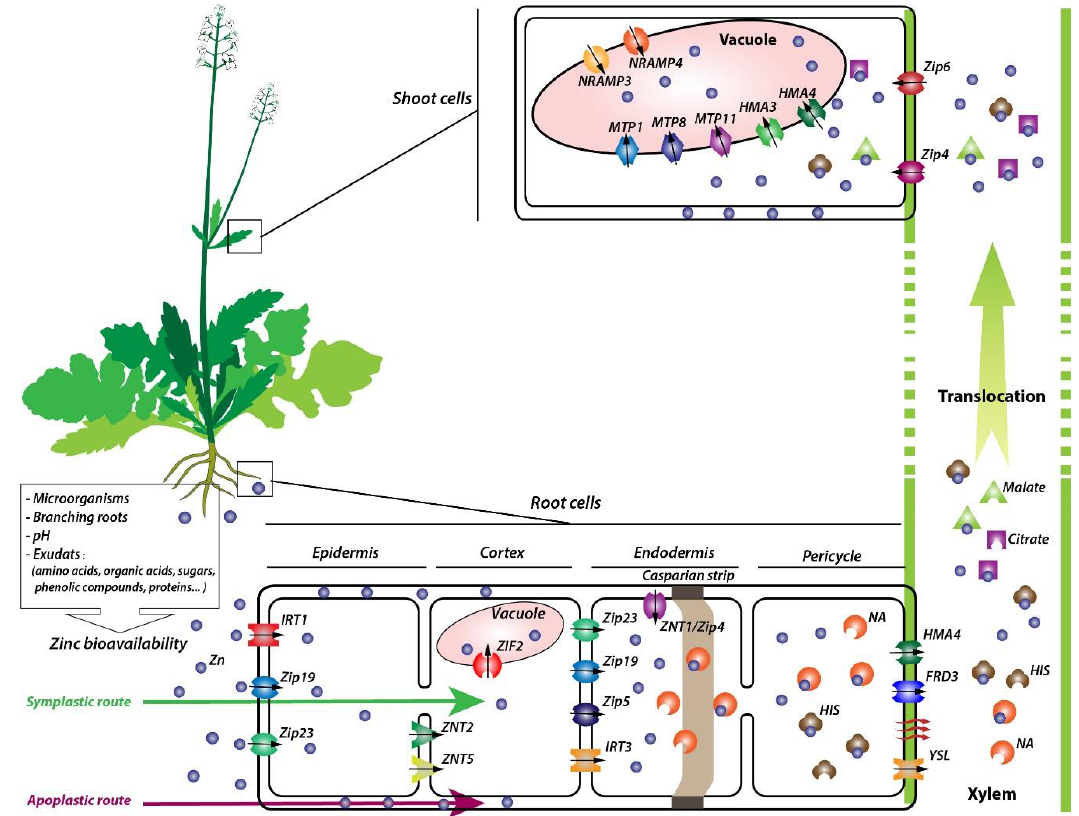
Figure 1. A model of the mechanisms that occur in hyperaccumulation plants upon exposure to zinc (Zn): Zn ion uptake, chelation, transport, and sequestration. Zn bioavailability can be influenced by several factors, such as microorganisms, branching roots, pH, and exudates. Once adsorbed by the roots, Zn can be absorbed by an apoplastic route: A passive di ff usion through cells, or by a symplastic route via transporters. Within the latter path, Zn absorption by epidermis cells is mainly promoted by IRT1, ZIP19, and ZIP23. To reach the cortex, Zn can be directly di ff used or by means of ZNT2 and ZNT5. Then, Zn can either be stocked in vacuoles (promoted by ZIF2) or transported to the endodermis through the following transporters: ZIP23, ZIP19, ZIP5, and IRT3. Zn following the apoplastic route is stopped by the casparian strip, and then enters the endodermis via ZNT1 / ZIP4. At this level, Zn can be chelated by nicotianamine (NA) or directly di ff used to pericycle cells where a part can also be associated to histidine (His). The unchelated Zn can reach the xylem through direct di ff usion or via YSL, ferric reductase defective 3 (FRD3,) and HMA4. Zn then crosses the xylem as a Zn-free form or coupled with His, citrate, or malate. To enter the leaf cells, Zn can passively penetrate in chelated forms or as the Zn-free form via ZIP4 and ZIP6 proteins. It is then sequestrated inside the vacuole through MTP1 (metal tolerance proteins 1), MTP8, MTP11, NRAMP3, NRAMP4, HMA3, and HMA4 transporters, or blocked in the cell